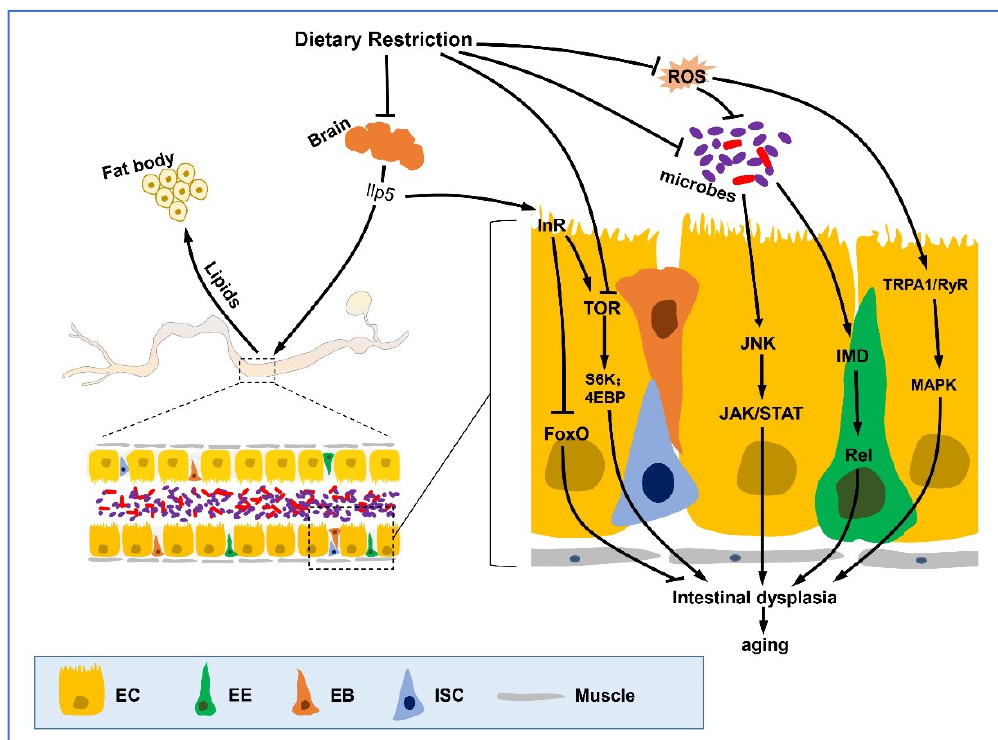
Figure 1. DR and DR mimetics improve gut epithelial function. In the fly gut, the epithelium consists of a monolayer of enterocytes (ECs) with interspersed enteroendocrine cells (EEs), and is basally located with intestinal stem cells (ISCs) and its daughter cells enteroblasts (EBs). The epithelial homeostasis of the gut is disrupted with aging, which causes dysplasia. Dietary restriction or its mimetics delay this process through various pathways including IIS signaling, TOR pathway, JNK, JAK/STAT pathway, IMD, and Ras/MAPK pathways. The communication of other organs with the intestine are also involved in the DR-mediated epithelial homeostasis and life extension effects. The secretion of Ilp5 from insulin-producing cells (IPCs) in the adult brain is inhibited by DR, which may signify a down-regulation of IIS, which then regulates TOR and FoxO indirectly. In addition, the fat body also mediates gut actions with aging by sharing lipid storage and metabolism with the intestine. Furthermore, DR reduces age-related intestinal flora growth rates, and down regulates JAK/STAT and IMD pathway, ultimately reducing ISC mis-differentiation and delaying functional degeneration of the intestine. Lines represent signaling pathways, arrows represent activation and blunt arrows represent inhibition.